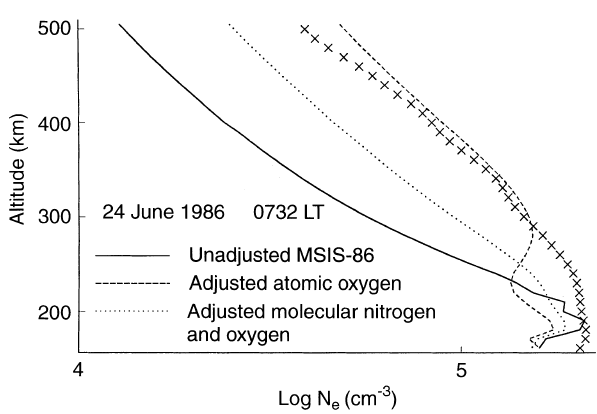
Fig. 3. Observed ( crosses ) and calculated ( lines ) electron density at 0732 LT for 24 June 1986. The solid , dashed , and dotted lines are the same as for Fig. 1